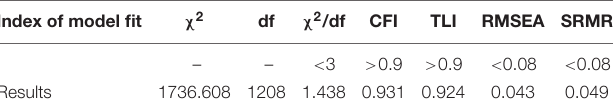
TABLE 2 | Indices of model